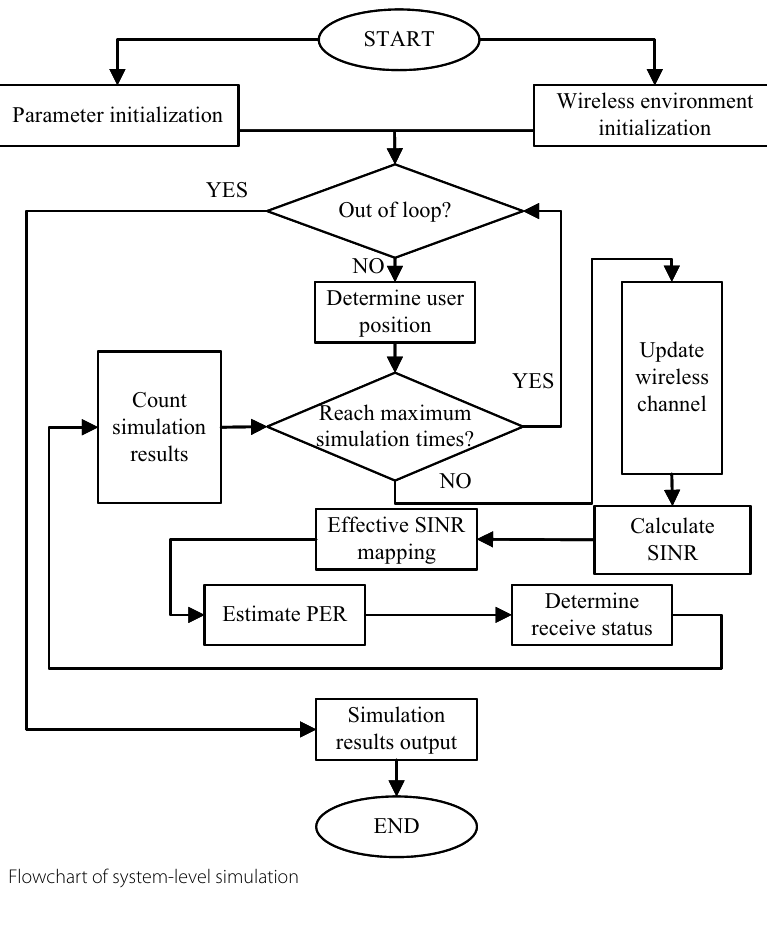
Fig. 7 Flowchart of system-level